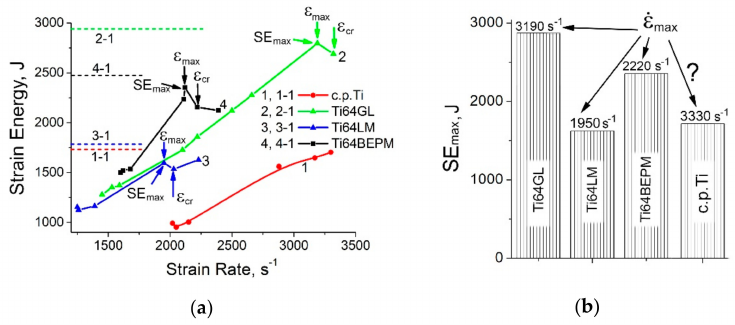
Figure 6. The strain energy for the studied Ti-based materials: ( a ) SE -strain rate dependence; ( b ) comparison of the maximum strain energy values ( SE max ) corresponding to the maximal strain rate . ε max (indicated by arrows), for which specimens do not crack during the SHPB